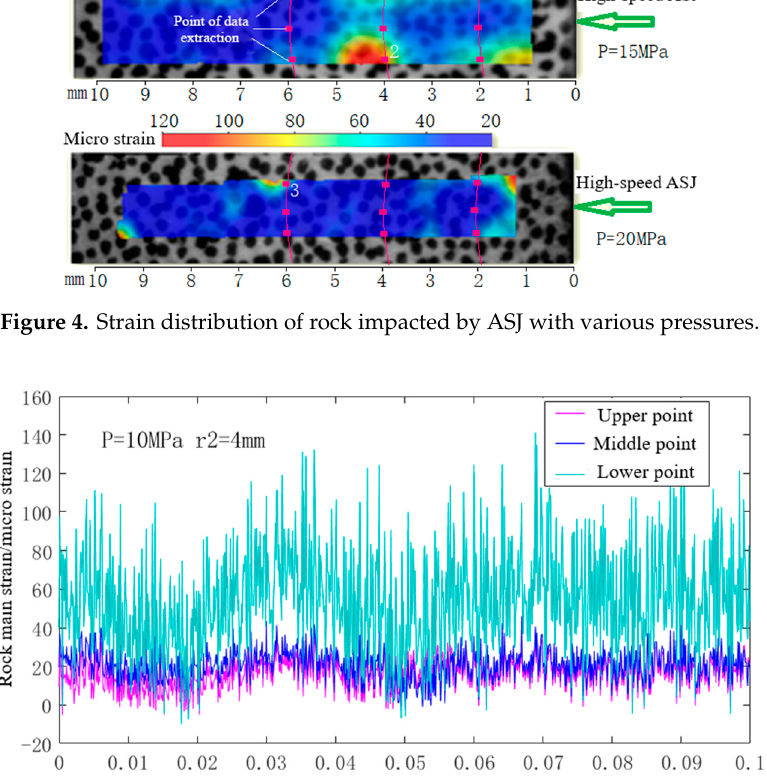
Figure 4. Strain distribution of rock impacted by ASJ with various pressures.